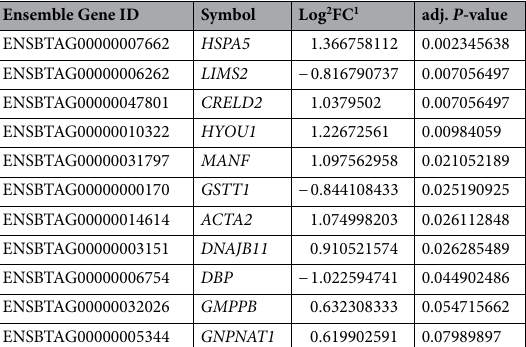
Ensemble Gene ID Symbol Log 2 FC 1 adj. P -value